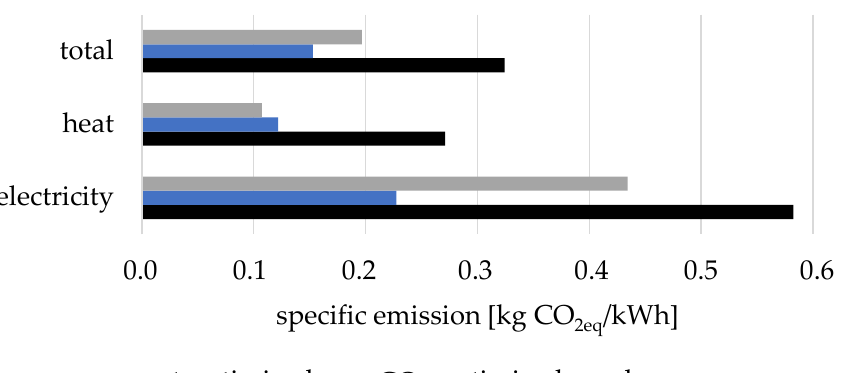
Figure 4. Overview on the specific emissions for each scenario in kg CO 2eq /kWh, without accounting for emissions with energy-related infrastructure. A distinction is made between the joint consideration of heat and electricity (=total) in kg CO 2eq /kWh and electricity and heat separately. In Figures 5–7, the distribution of environmental impacts is explored, showing which impacts occur due to either electricity or heat supply within all three scenarios. The colors supply (blue). If a technology provides both heat and electricity, the color orange is used. scenario.